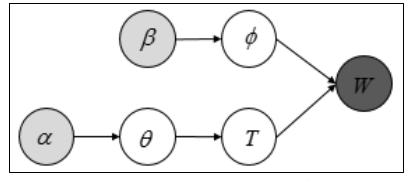
Figure 1. The generation process of LDA